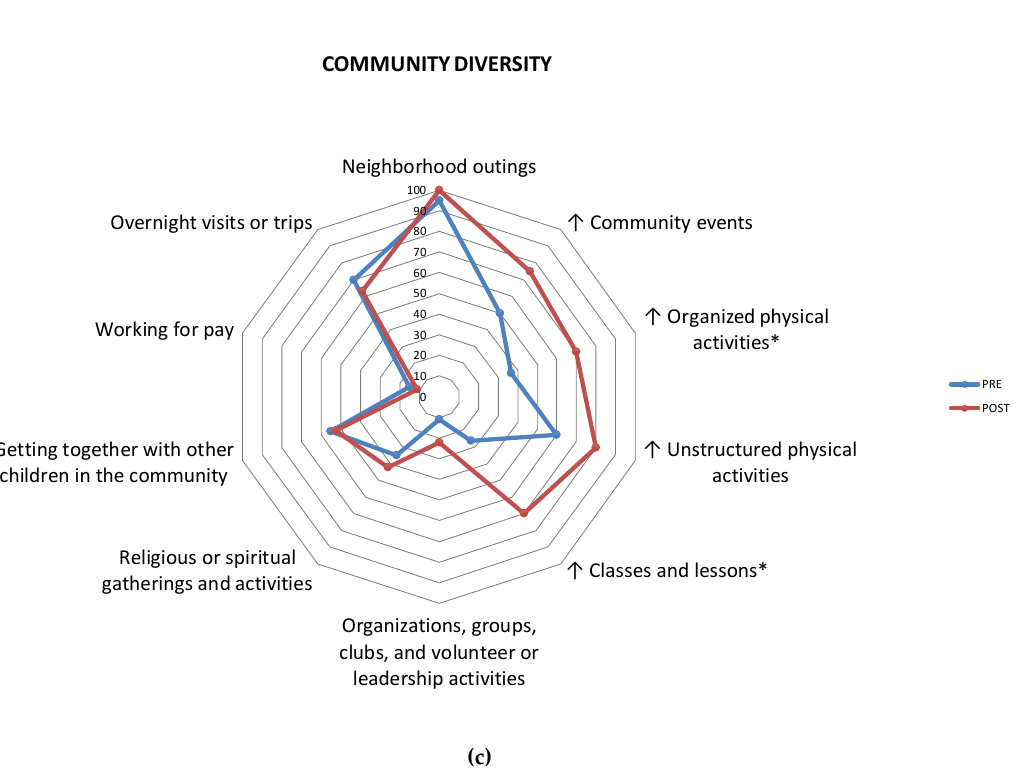
Figure 2. Percentage of youth (n = 18 to 20) participating in each activity in the home ( a ), school ( b ), and community ( c ) settings. ↑ / ↓ = Increase / decrease in at least 20% of sample. * p < 0.05. Int. J. Environ. Res. Public Health 2020 , 17 , x